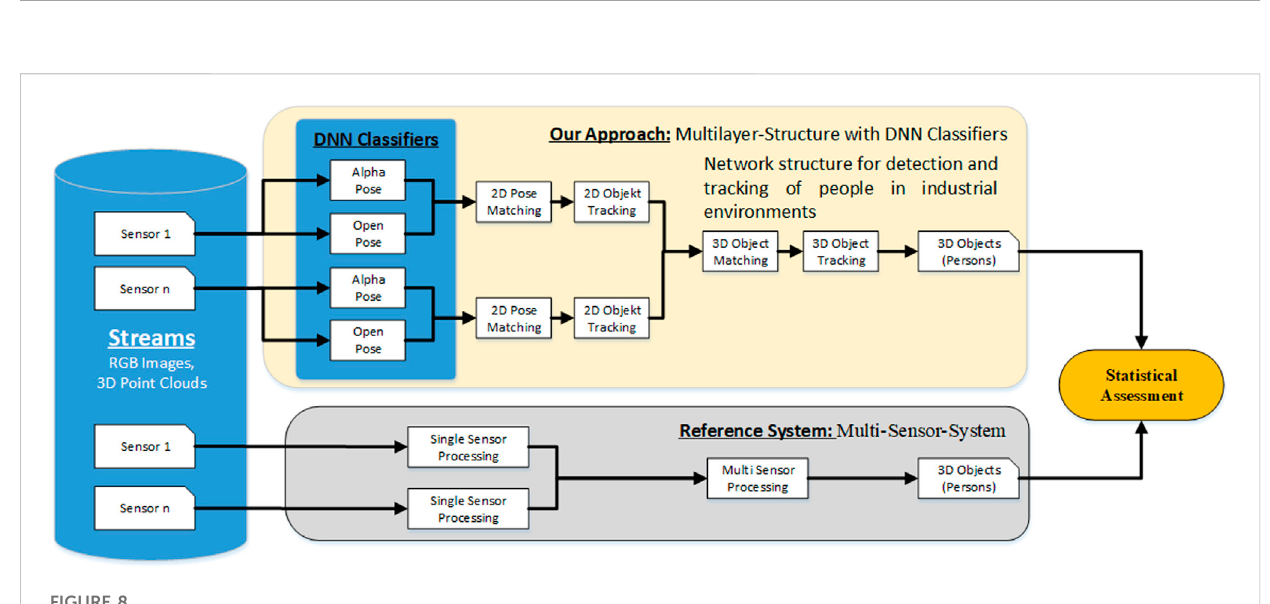
FIGURE 8 Architecture for comparing Results of Annotation Tool and Reference